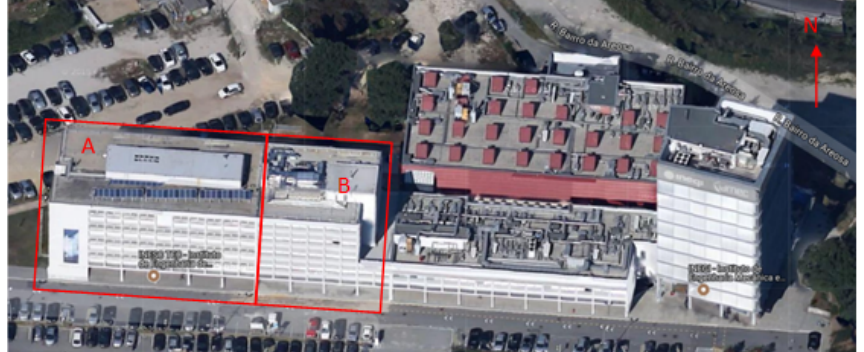
Figure A1. INESC TEC buildings.